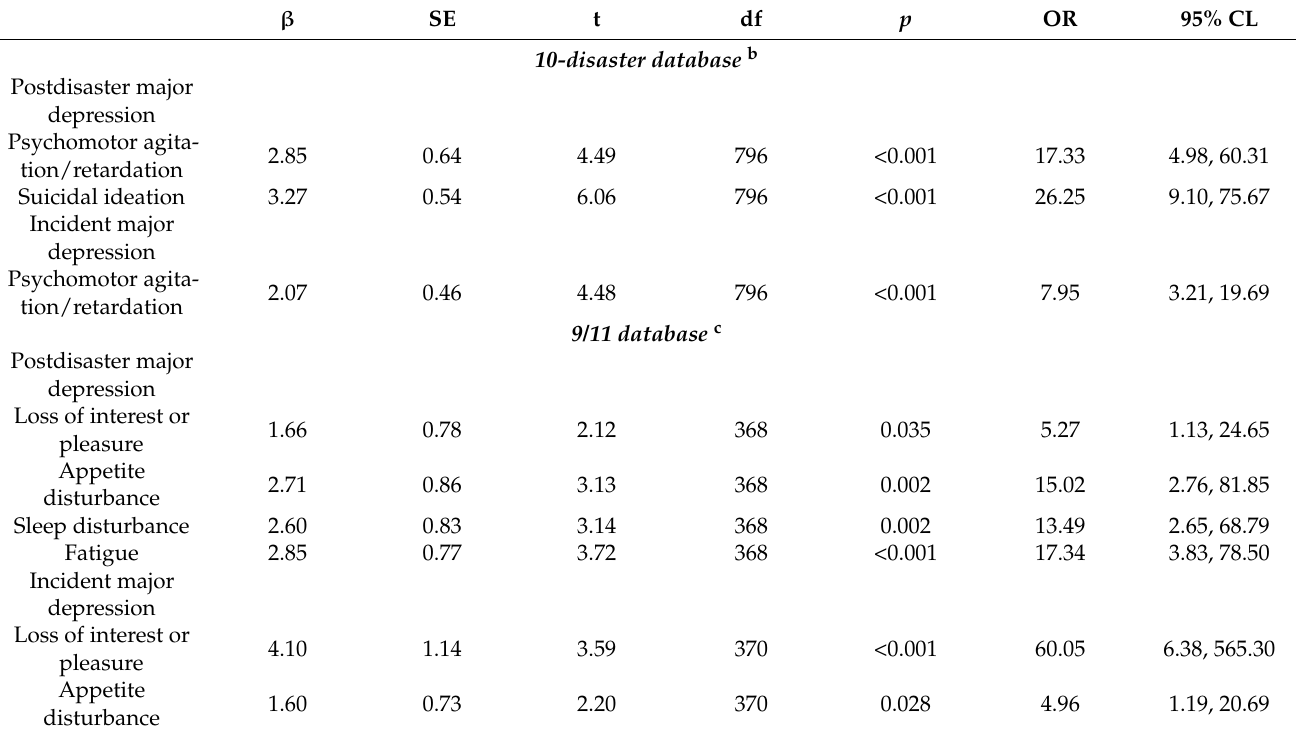
Table 3. Multivariate models predicting postdisaster and incident major depression in the 10-disaster and the 9/11 databases a . β SE